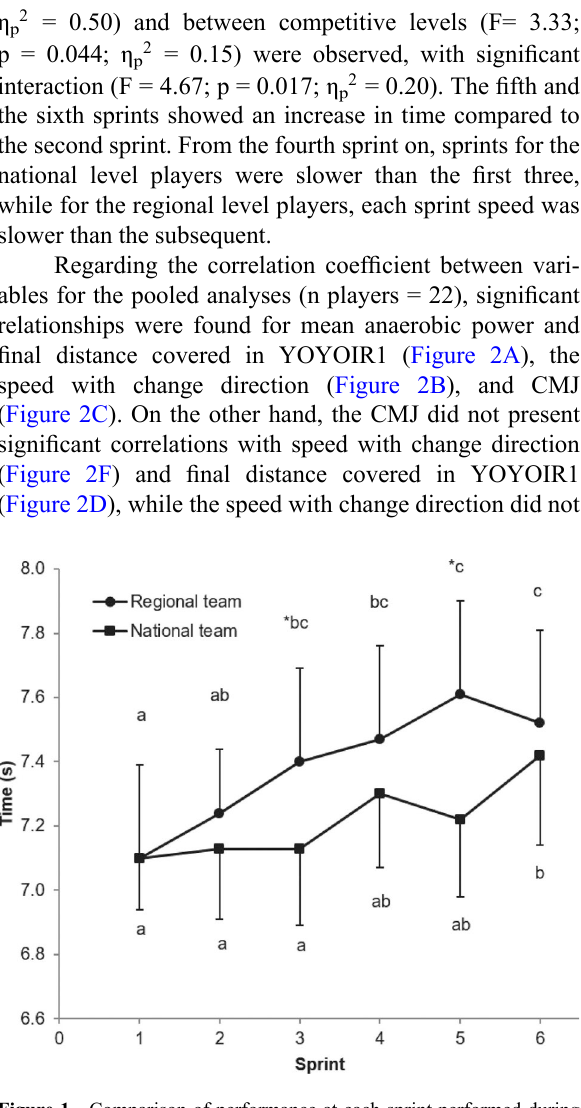
Figure 1 - Comparison of performance at each sprint performed during Repeated Shuttle Sprint Ability test. *Significant difference between teams p < 0.05. Letters different indicate significant difference p